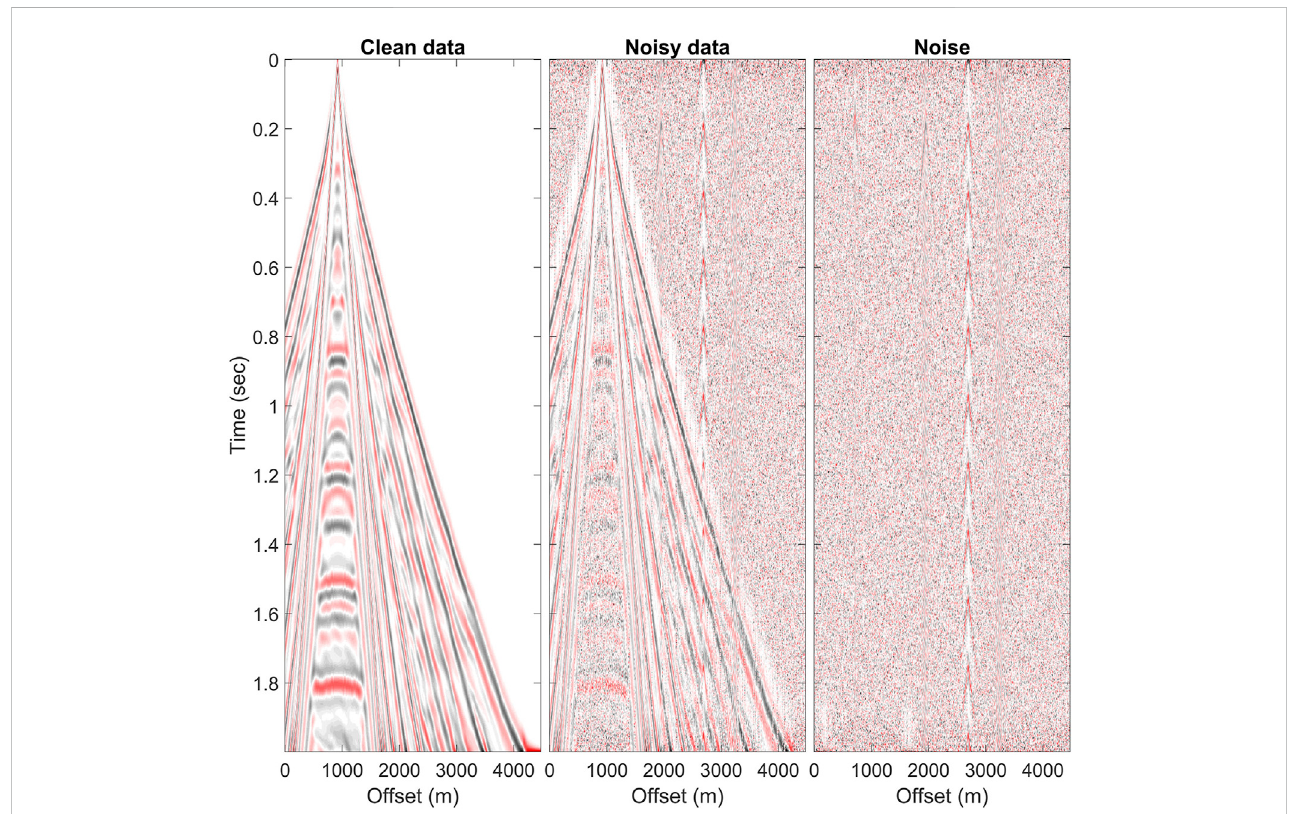
FIGURE 3 Synthetic clean data, noisy data, and the noise are shown with the AGC applied. The noisy data, the superposition of the clean data and the noise, has an RMSE equal to